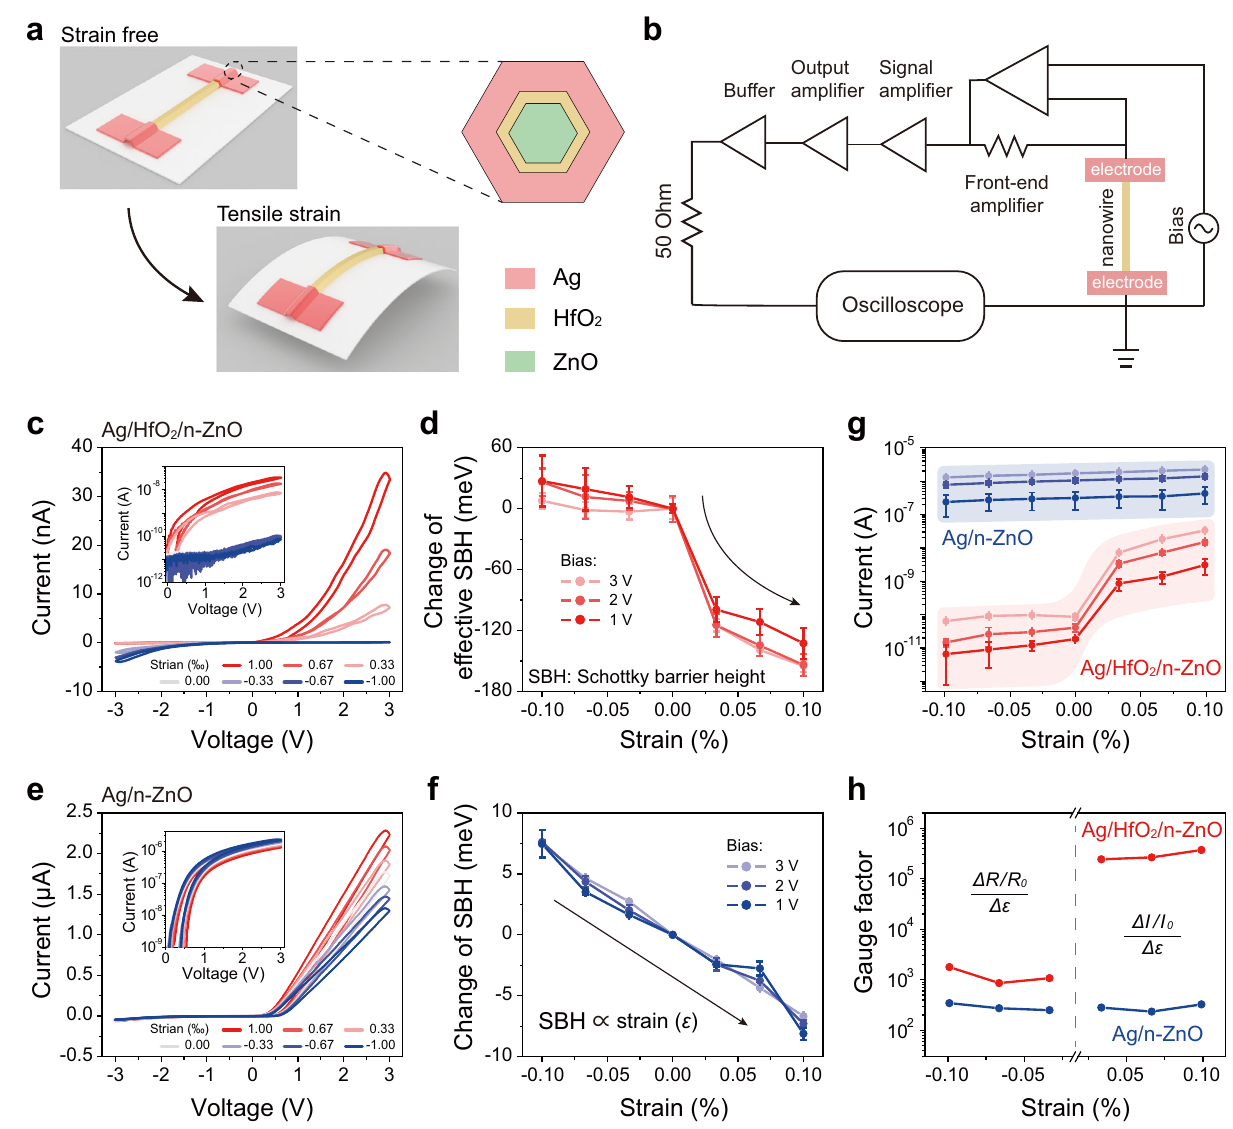
Fig. 2 The interface gating effect of strain sensor based on piezotronic tunneling junction. a Cyclic bending of the fl exible substrate introduces a strain to the piezotronic tunneling strain sensor (PTSS). The strain of the nanowire can be approximately equivalent to the strain of the outer surface of the fl exible substrate. b Schematic diagram of the measurement setup. Using this equipment, a sweeping bias between − 3 and + 3 V was applied and the current was measured simultaneously. c Strain-dependent I – V characteristics of Ag/HfO 2 /n-ZnO PTSS. The inset is the semilogarithmic forward curves. As the tensile strain increases, the current increases drastically. d Change of effective Schottky barrier height (SBH) derived from the I – V curves in c . The rapidly changed SBH between the strain of 0.00 – 0.033% indicates that a small tensile strain enables the occurrence of carrier tunneling. e Strain-dependent I – V characteristics of Ag/n-ZnO Schottky-junction-based strain sensor (SSS). The inset is the semilogarithmic forward I – V curves. f Change of effective SBH derived from the I – V curves in e . A linear correlation between the change of SBH with applied strain follows the classic piezotronic theory. g ln( I ) versus strain curves of Ag/HfO 2 /n-ZnO device (red) and Ag/n-ZnO device (blue). h Gauge factor derived from g as a function of strain to assess the performance of PTSS and SSS. The error bars in d , f , and g are the standard